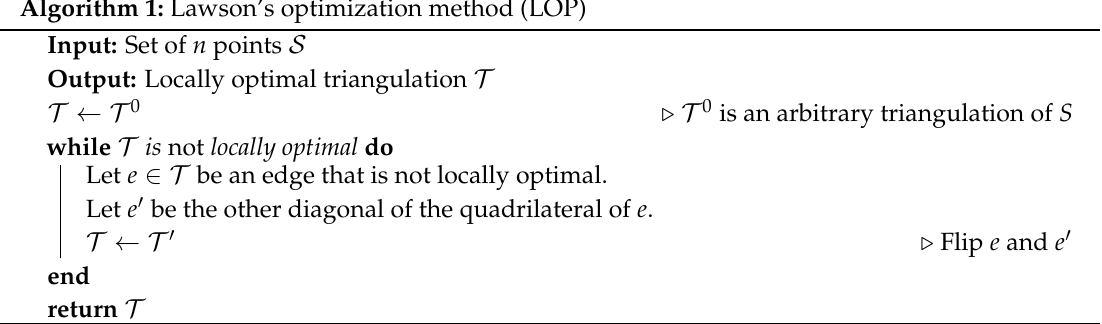
Algorithm 1: Lawson’s optimization method